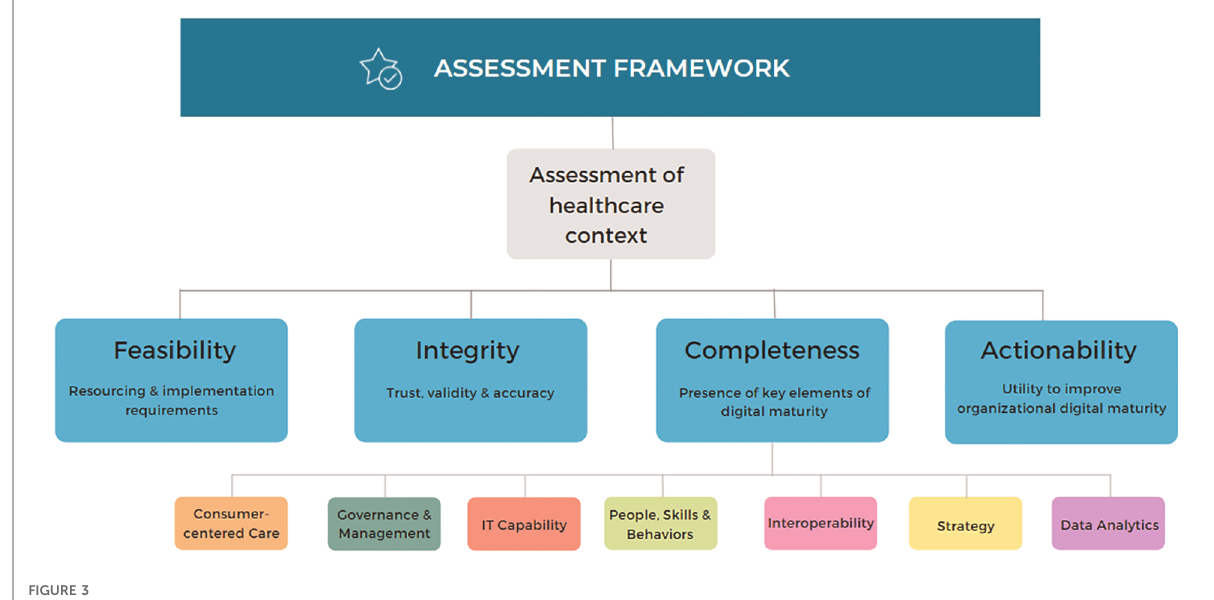
FIGURE 3 Framework to evaluate digital health maturity